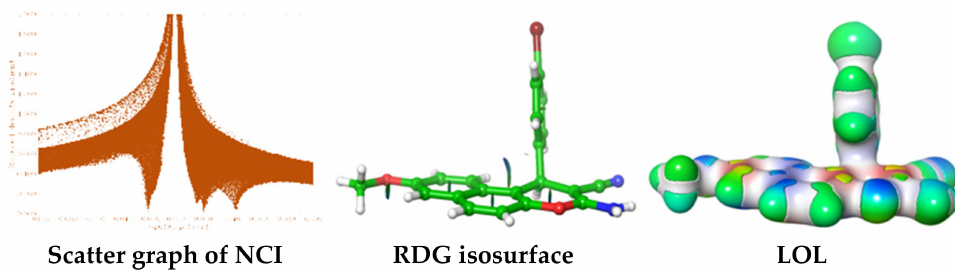
Figure 4. Different types of the weak interactions for compound 4 .